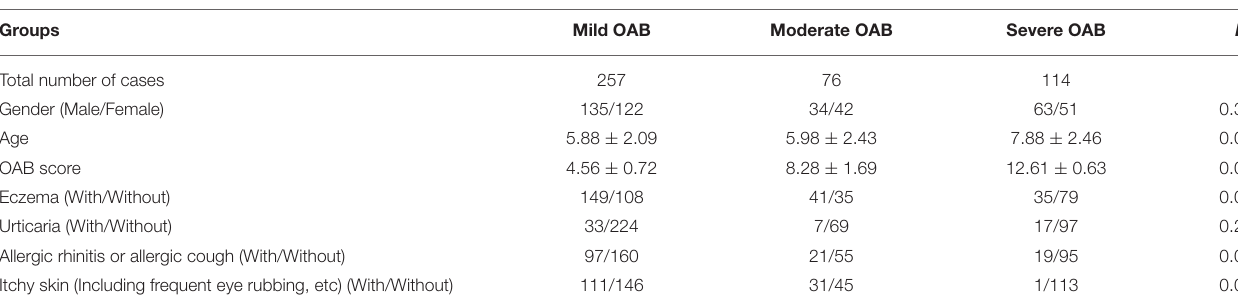
TABLE 3 | Grouping of children with